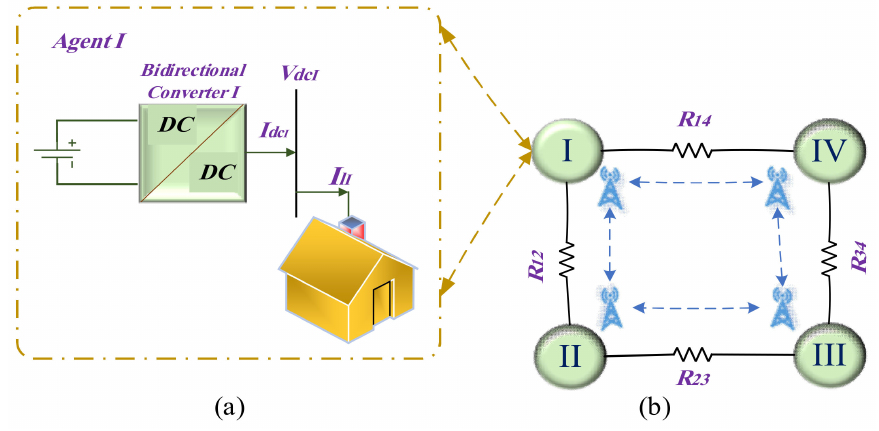
Figure 4. Simulated system: ( a ) unit type; ( b ) Cyber-physical DC-MG with four resources. Table 2. Simulated system parameters.